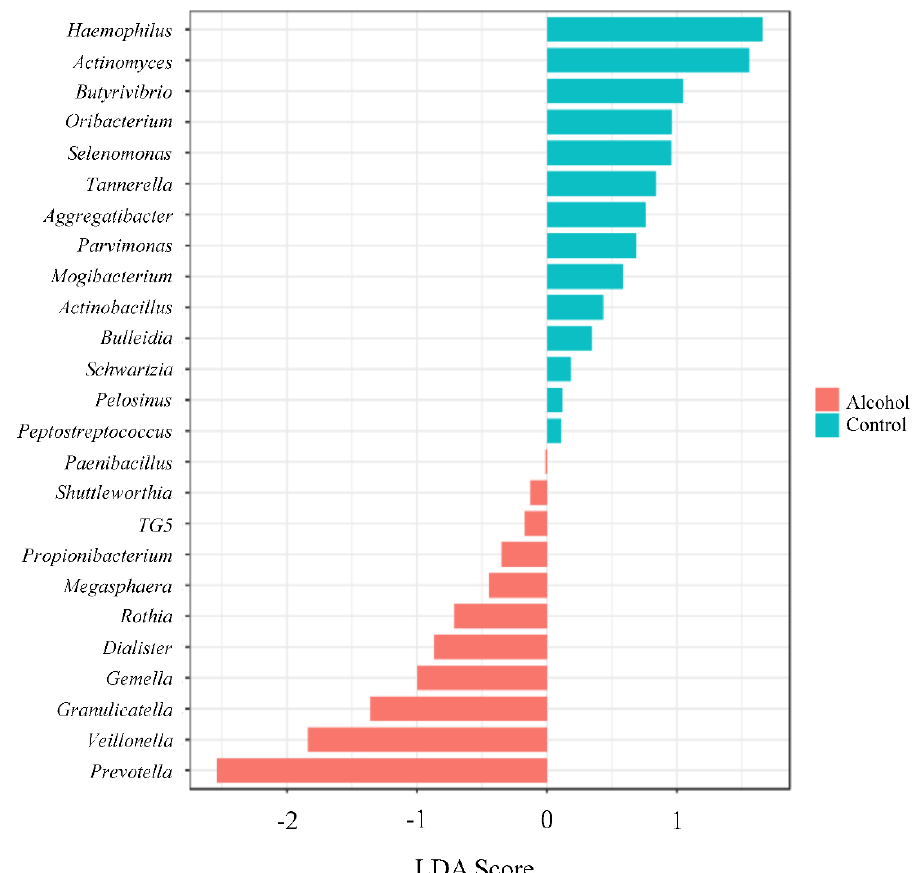
Figure 7. The di ff erences between the groups were evaluated by using the linear discrimination analysis e ff ect size (LEfSe). The LEfSe method, which is a biomarker discovery, uses Kruskal–Wallis sum test and linear discrimination analysis to identify significant di ff erence abundance and estimated the e ff ect size, respectively. The bar graph shows the LDA scores of (at most) top 25 significant bacteria. The colors (alcohol users = red, control = blue) represent which group was more abundant compared to the other group at genus level. The p value cut-o ff was 0.1 with an adjusted false discovery rate. Cognitive composite (CC) scores in AG were negatively correlated with salivary MDC and plasma and salivary IL-1 β (r s = − 0.46, p = 0.01; r s = − 0.38, p = 0.05; and r s = − 0.53, p = 0.01, respectively). Higher expression of salivary and plasma IL-6 are inversely correlated with CC in the AG (r s = − 0.40, p = 0.04; r s = − 0.38, p = 0.05, respectively). On the contrary, the AG showed positive correlations of CC salivary TNF- β was negative correlated with CC scores in the CG (r s = − 0.54, p =